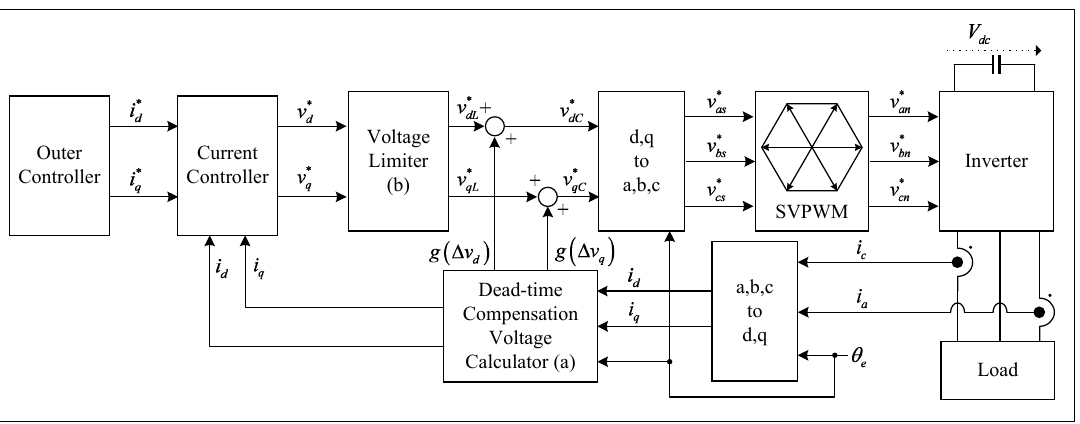
Figure 18. The control block diagram of three-phase VSI with proposed DTCS.